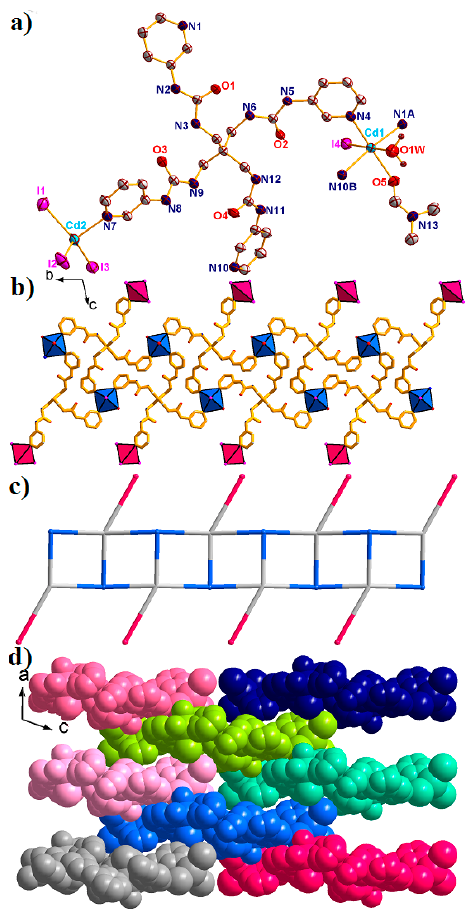
Figure 5. ( a ) The asymmetric unit of complex 4 with 50% probability ellipsoids. (Symmetry codes: A: 2 − x , 1 − y , − 1 − z ; B: 2 − x , − y , − 1 − z ). ( b ) The 1D [Cd 2 (L)] n fishbone chain of 4 viewed along the a direction. ( c ) The simplified 1D fishbone chain structure. ( d ) Space filling 3D supramolecular structure of 4 viewed along the b direction. All solvents have been omitted for clarity.